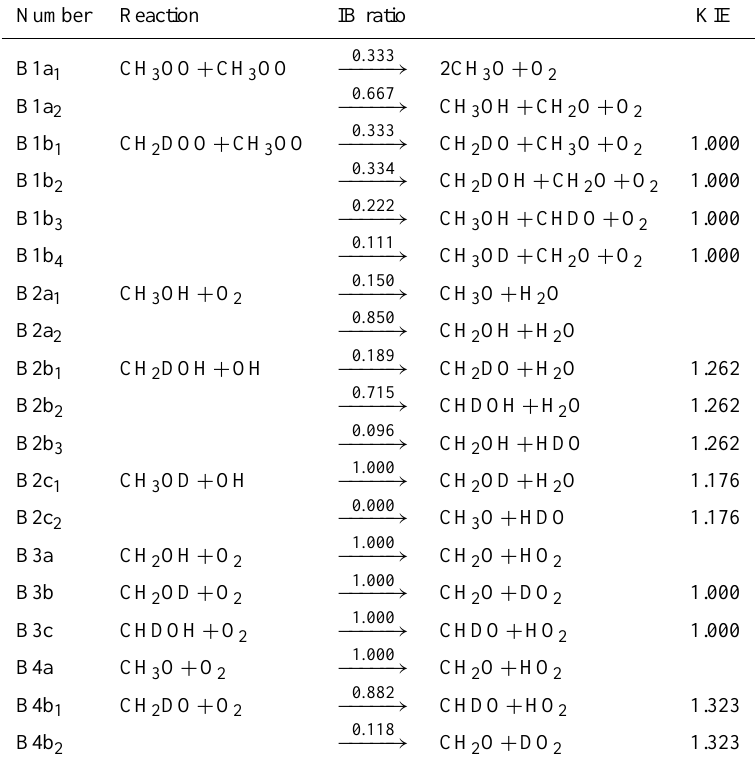
Table A2. Reactions following the CH 3 OO self reaction (Sander et al., 2006; Pieterse et al.,